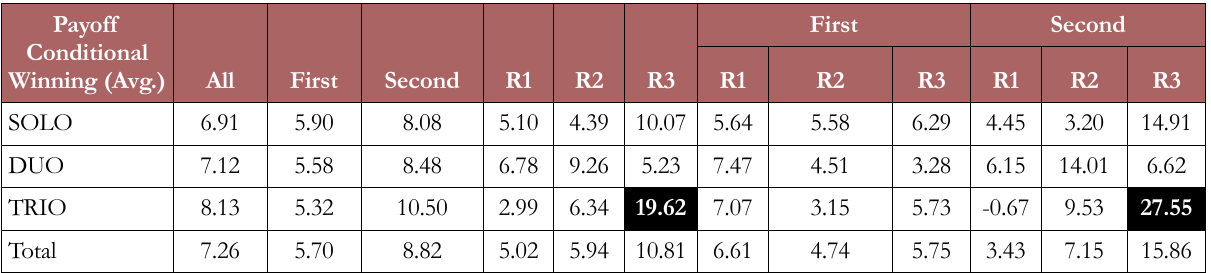
Table 8. Payoff Conditional on Winning (Avg.): pairwise differences in terms of size by right and mechanism